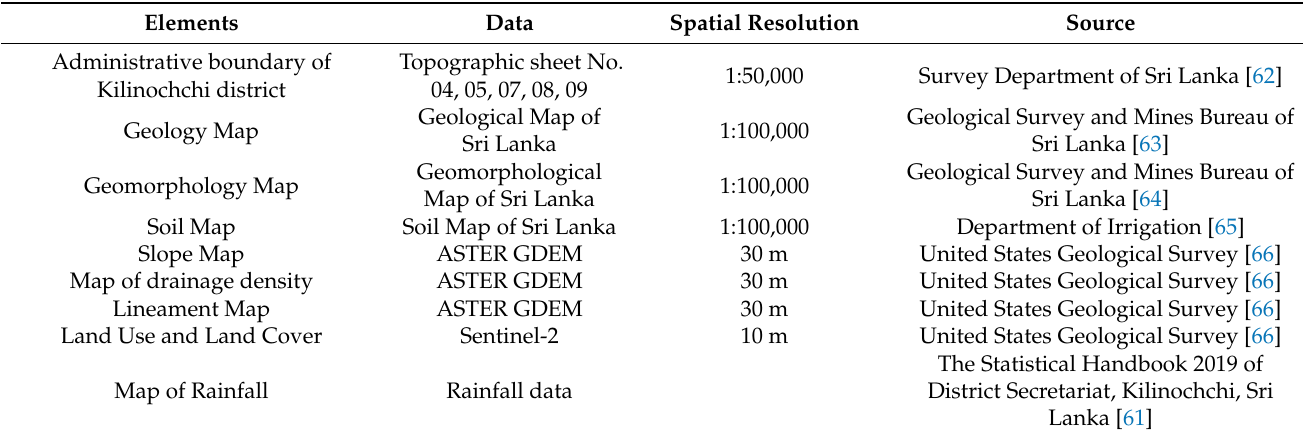
Figure 1. Location map of the study area: ( a ) Map of South Asia; ( b ) location of Sri Lanka; and ( c ) the extend of Kilinochchi district. Table 2. List of data layers and their